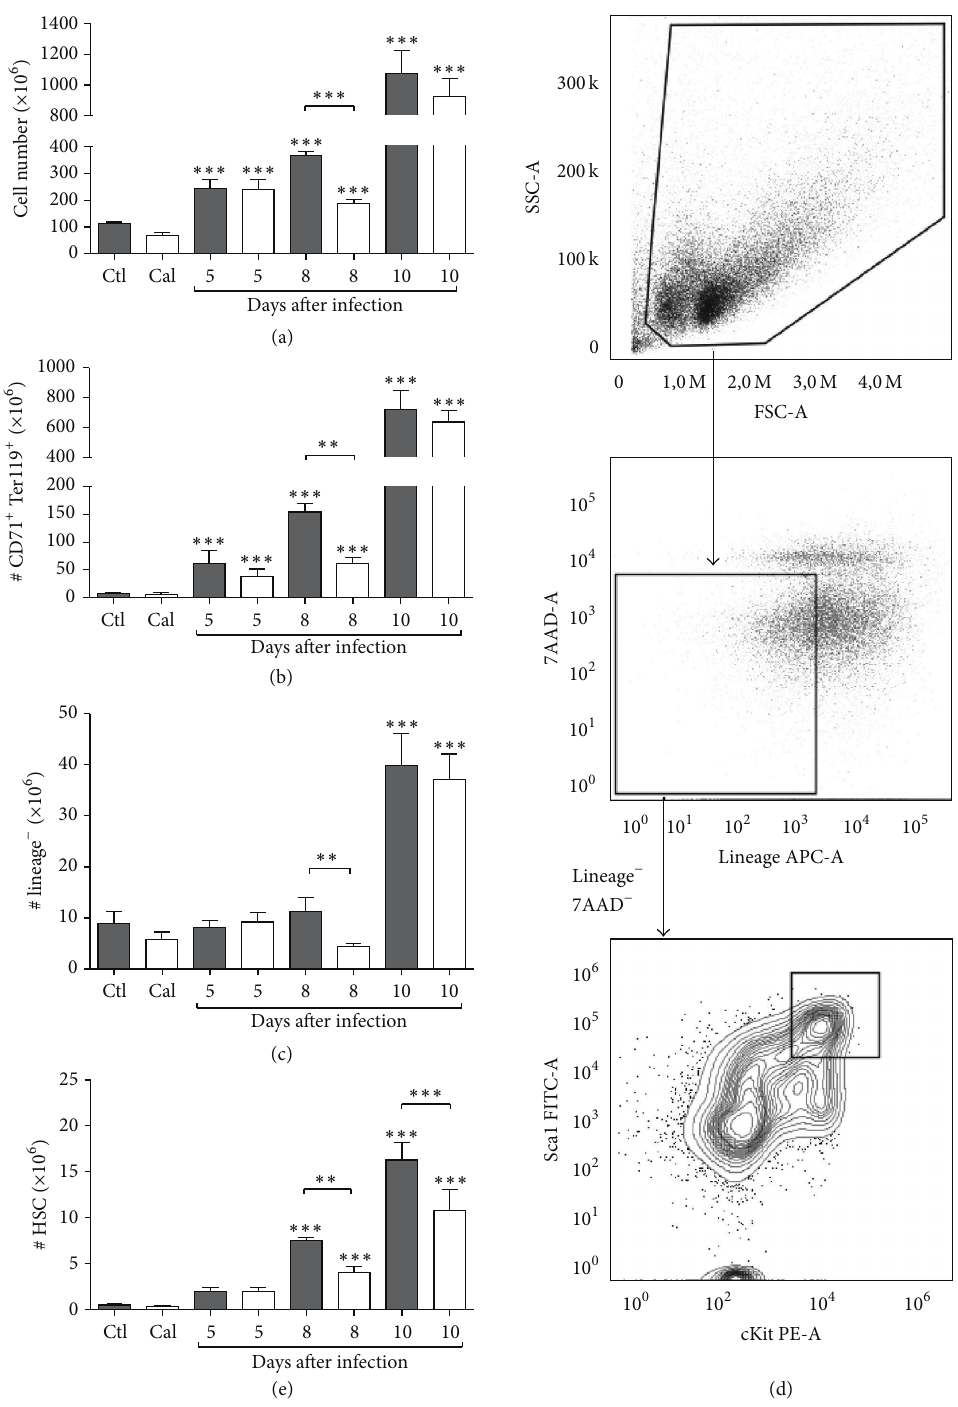
Figure 3: Modulation of splenic hematopoiesis during Plasmodium infection by calcitonin. Mice were treated with calcitonin (white bars) or with PBS (grey bars) during 5 consecutive days and were infected with P. c. adami DK parasites (10 5 pRBCs) on the 3rd day of treatment. Data from uninfected controls (Ctl, Cal 𝑛 = 3 ) is included for comparison. Infected mice were sacrificed at 5 ( 𝑛 = 8 ), 8 ( 𝑛 = 8 –12), and 10 ( 𝑛 = 3 -4) days after infection and the spleen was aseptically recovered for analysis of numbers of total cells (a), erythroid cells (b), lineage − cells (c), and hematopoietic stem cells (e) by cytofluorometry. Identification panel of hematopoietic stem cells (Lineage-7AAD − Sca1 + cKit + ) by cytofluorometry is also represented (d). Data are mean ± SEM and values are compared to respective uninfected control mice and between the two infected groups using a one-way ANOVA test. ∗ 𝑃 < 0.05 ; ∗∗ 𝑃 < 0.01 ; ∗∗∗ 𝑃 < 0.001